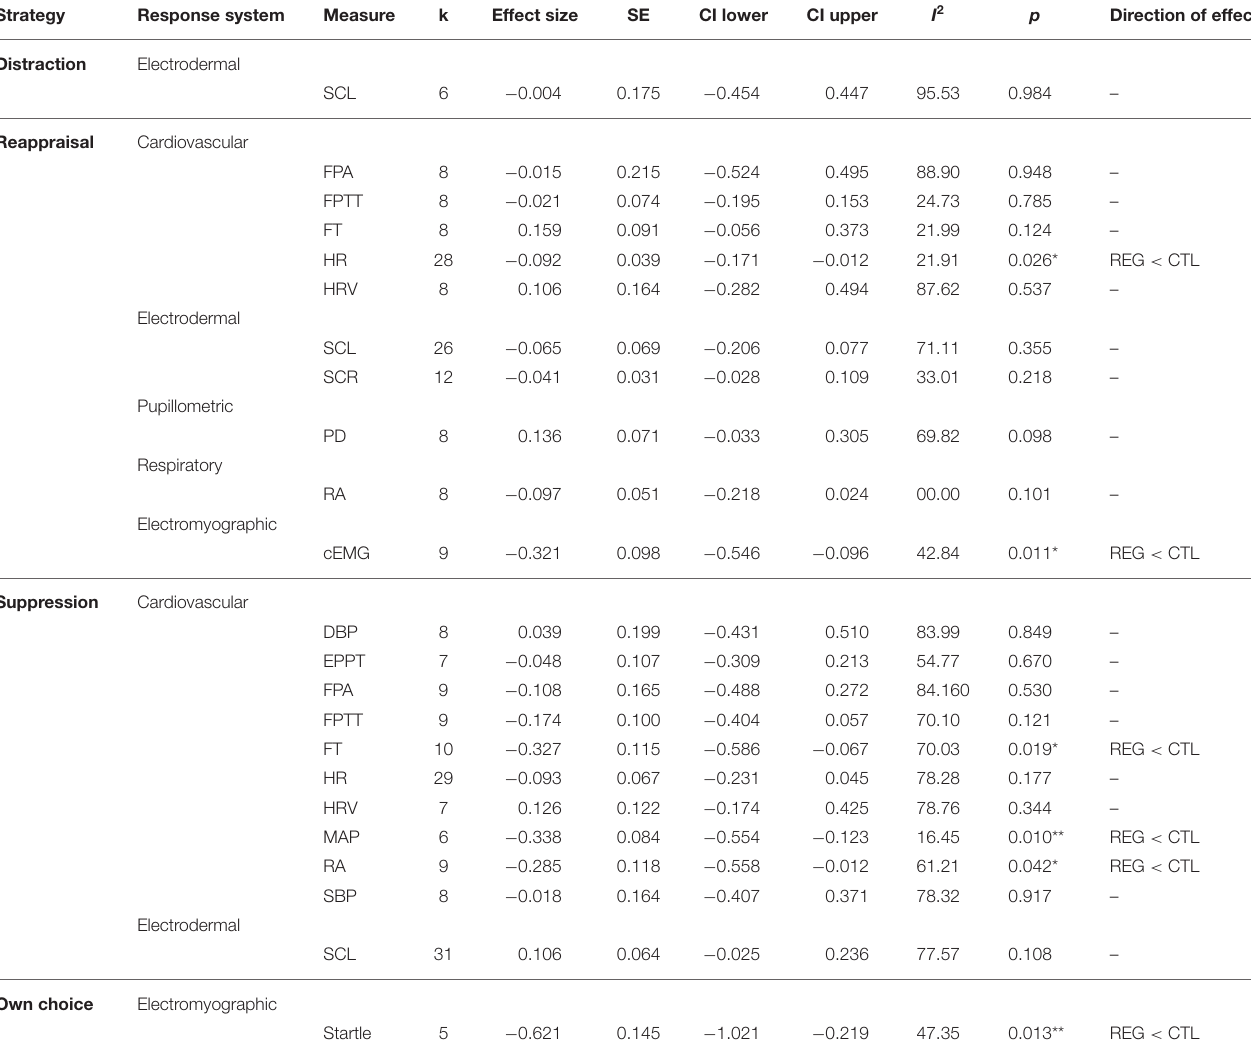
TABLE 4 | Mean computed effect sizes for each emotion regulation strategy and psychophysiological measure.